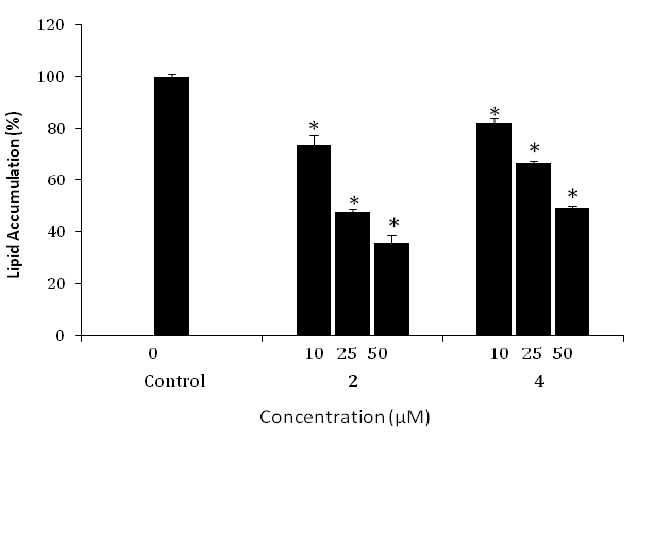
Figure 2. Effect of compounds 2 and 4 on fat accumulation in 3T3-L1. Results are expressed as mean ± SD of three independent experiments, each performed using triplicate wells. * p < 0.01 compared with